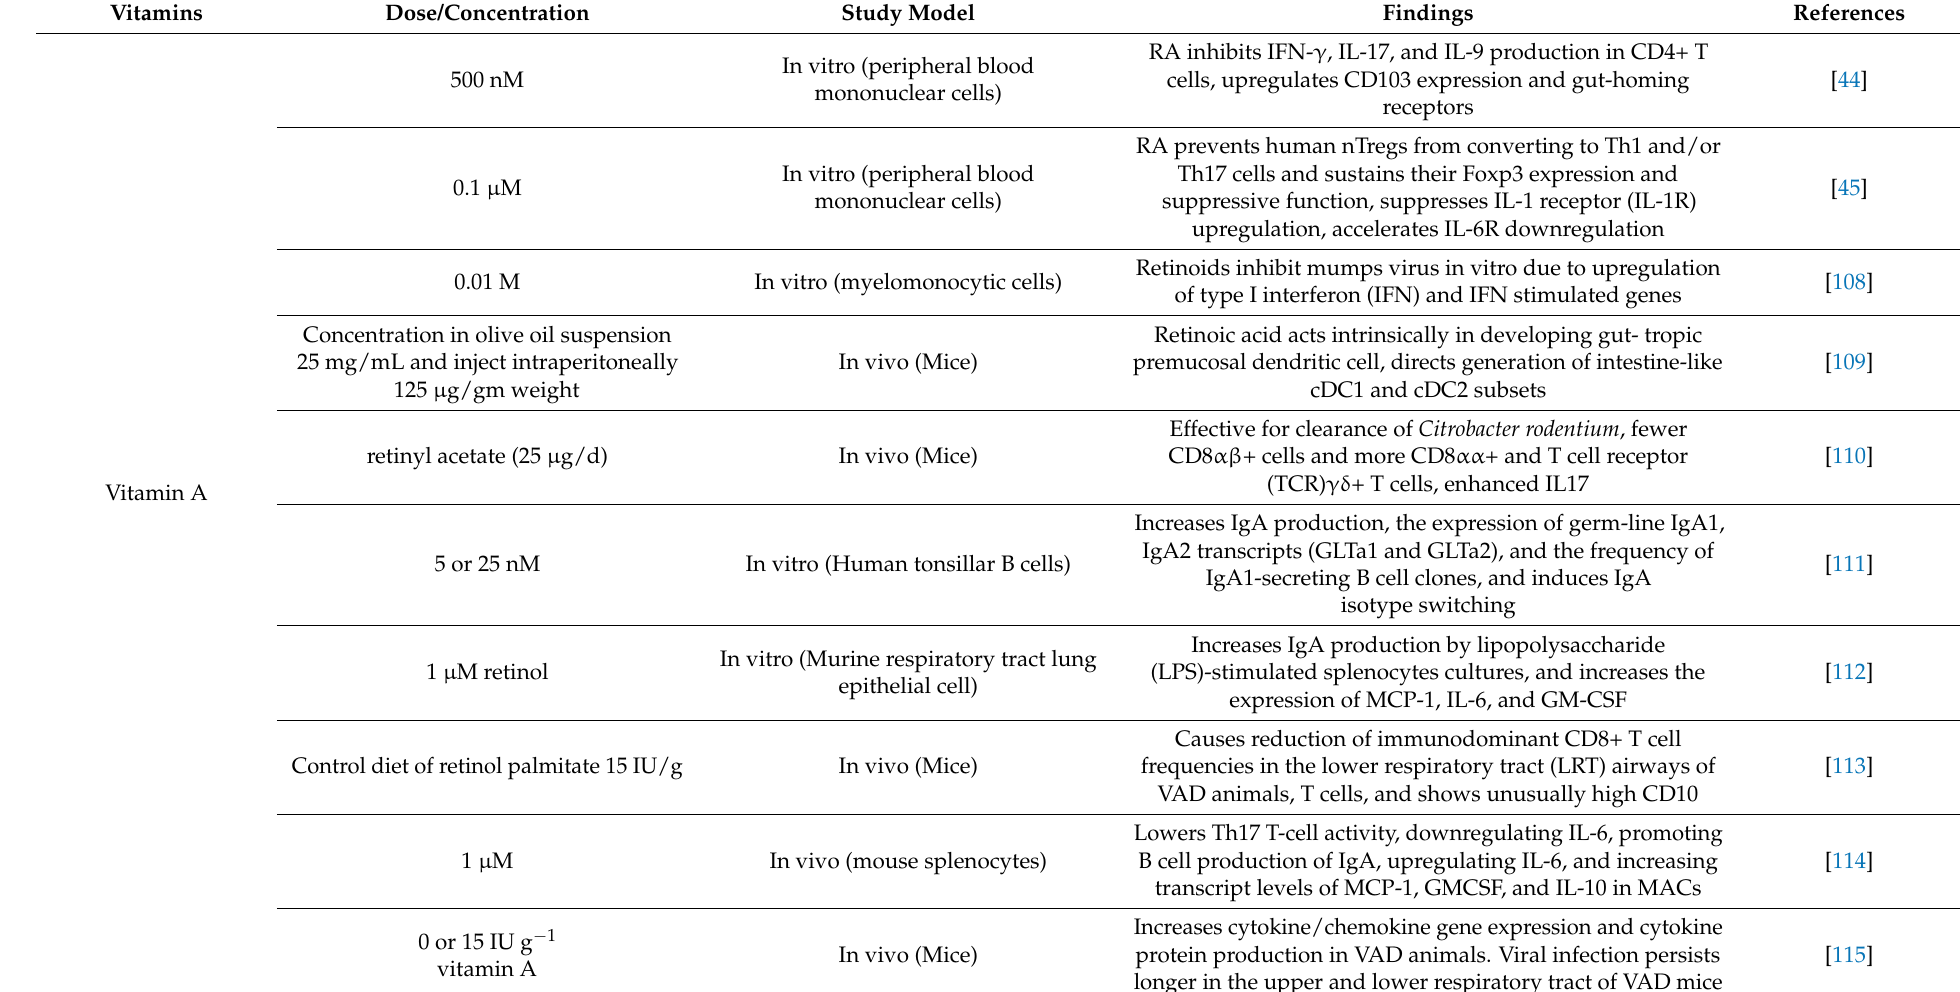
Table 1. The immunomodulatory roles of vitamins, reported by experimental